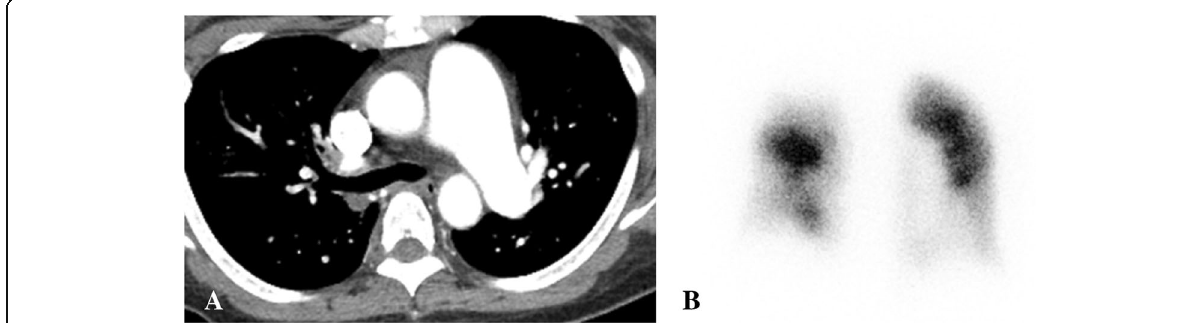
Fig. 2 Pre-balloon pulmonary angioplasty images. a Contrast-enhanced computed tomography showed no emboli in the pulmonary arteries. b Lung perfusion scan showed multiple blood flow